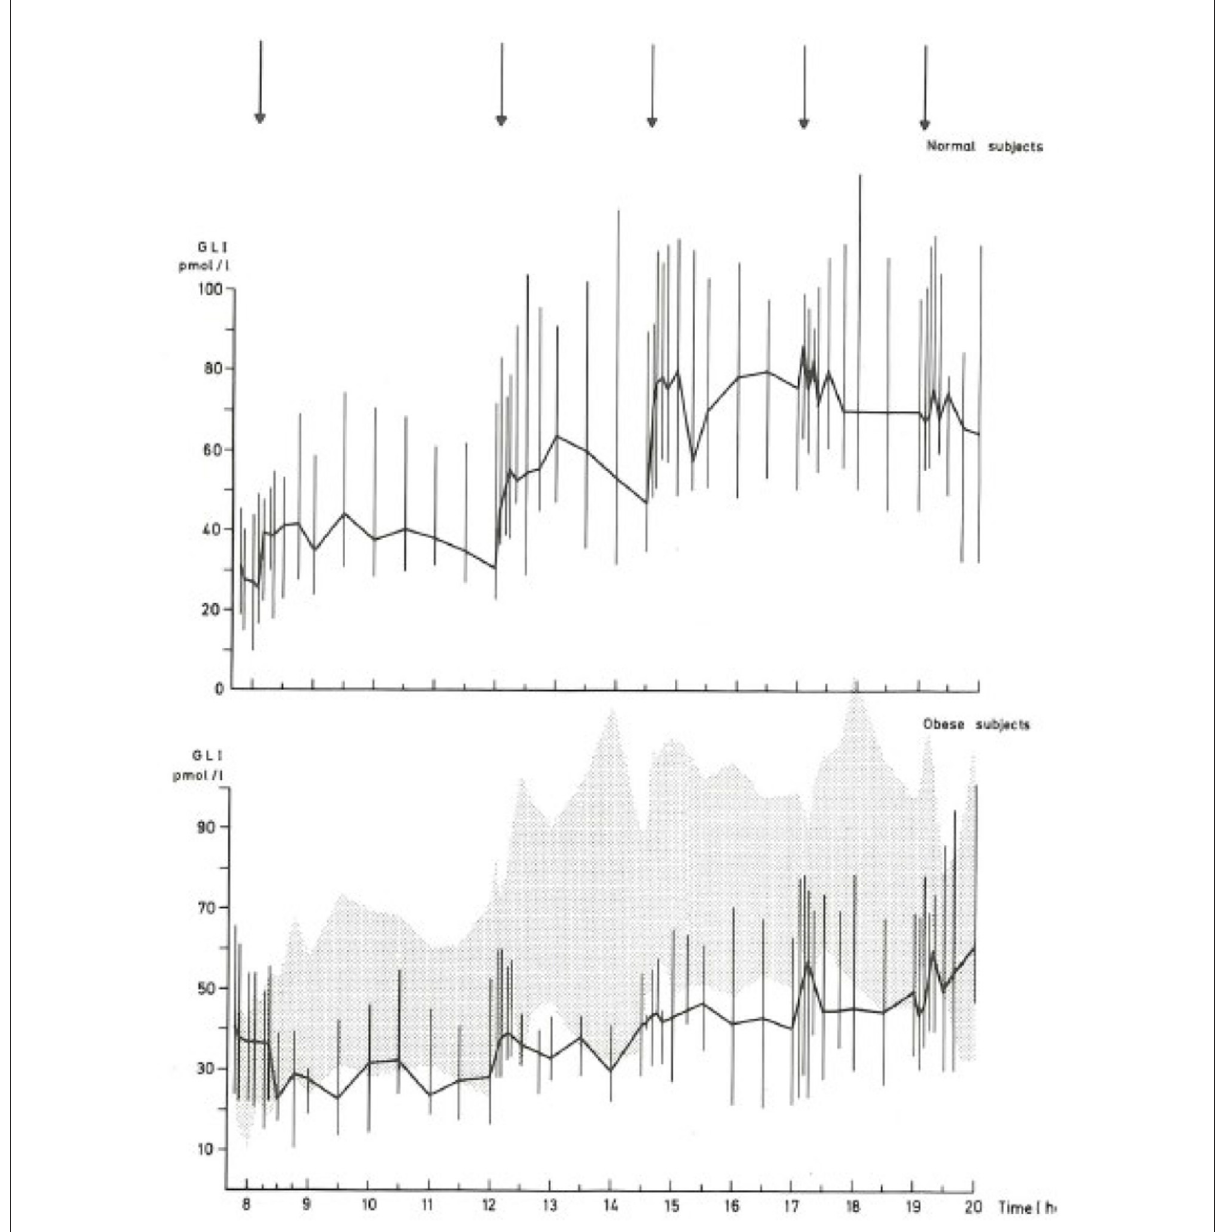
FIGURE2 Diurnal profile of enteroglucagon (glicentin + oxyntomodulin) in plasma from lean and morbidly obese subjects throughout the day (38). Full lines: median values; vertical bars: total range; shaded area: total range ( = 95% confidence intervals) of healthy subjects. Arrows: